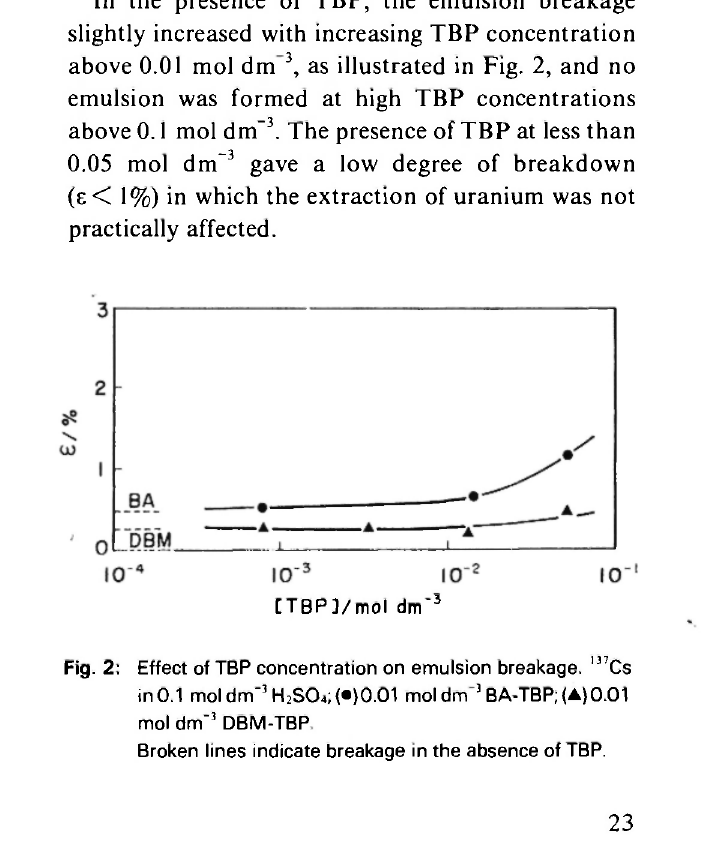
Fig. 2: Effect of TBP concentration on emulsion breakage. " 7 Cs inO.1 mol dm" 3 H2SO4; (·)0.01 mol dm ' BA-TBP; (A)0.01 mol dm" 3 DBM-TBP Broken lines indicate breakage in the absence of